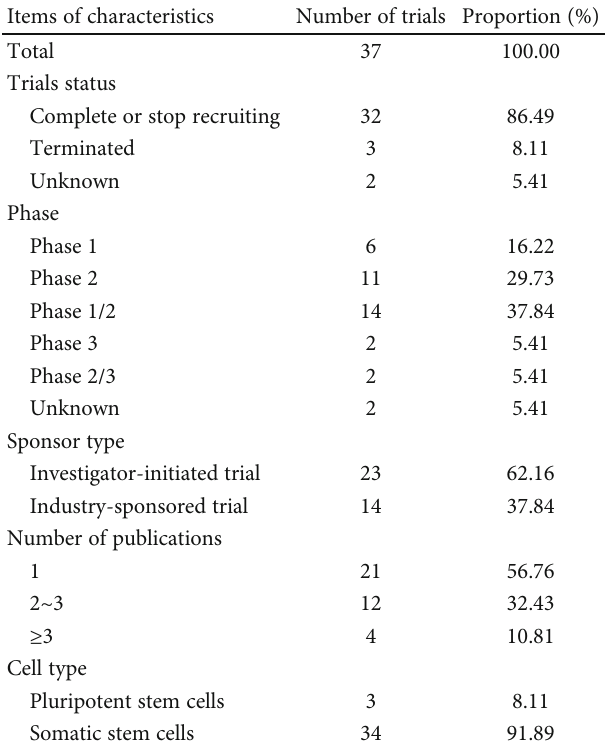
Figure 3: Searching and screening of stem cell clinical trials eligible for validation of quality assessment Table 1: Basic characteristics of included stem cell studies for validation of quality assessment tool.